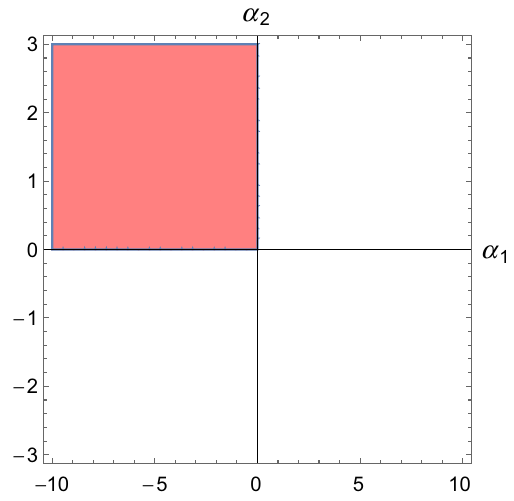
Fig. 1 The non-exclusive existence regions for the P 2 + critical line ( ξ